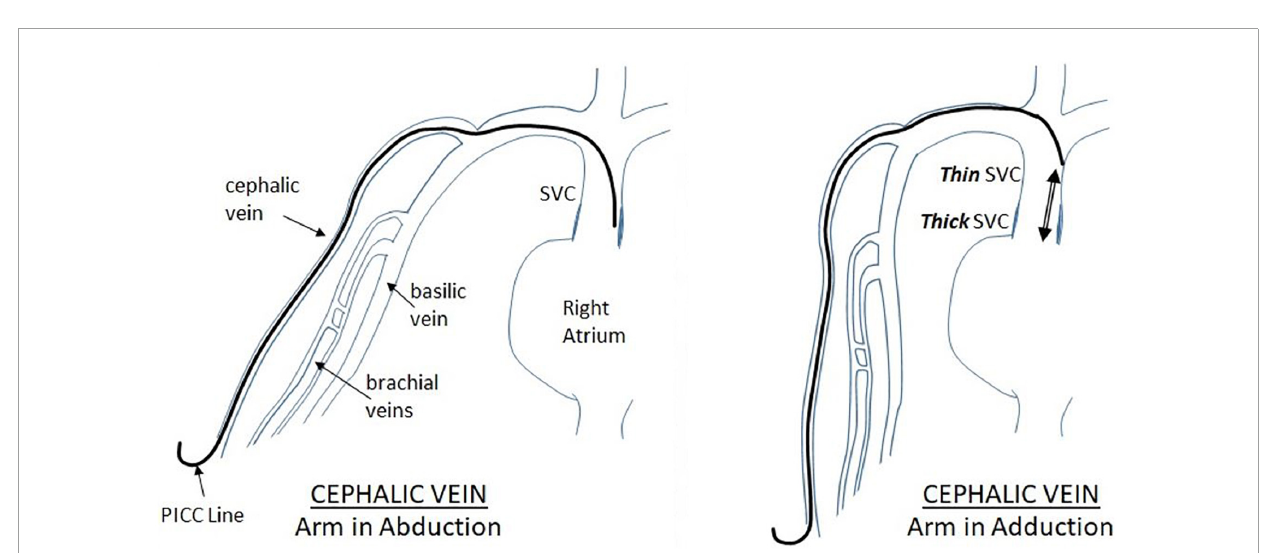
FIGURE4 Displacement of PICC inserted through the cephalic vein during arm movement. As illustrated in the figure, when the upper extremity is moving from abduction to adduction position, the PICC inserted via the cephalic vein moves in a cephalic fashion, away from the heart.